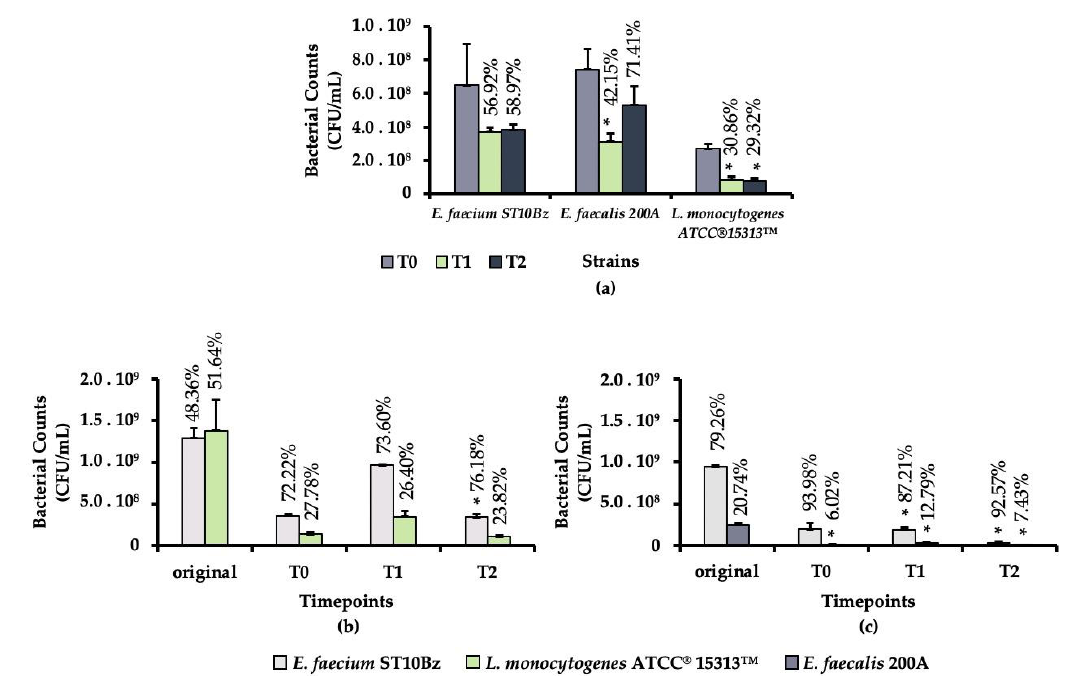
Figure 4. ( a ) Survivability of the individual strains under gastrointestinal tract (GIT) conditions. Proportional presence of E. faecium ST10Bz and test organisms: ( b ) co-cultures of E. faecium ST1 and L. monocytogenes ATCC ® 15313 ™ , ( c ) co-cultures of E. faecium ST10Bz and E. faecalis 200A. Timepoints T1 and T2 represent exposure times of either 1 h or 3 h simulation of the stomach or small intestine, respectively. Asterisks indicate statistically significant differences.